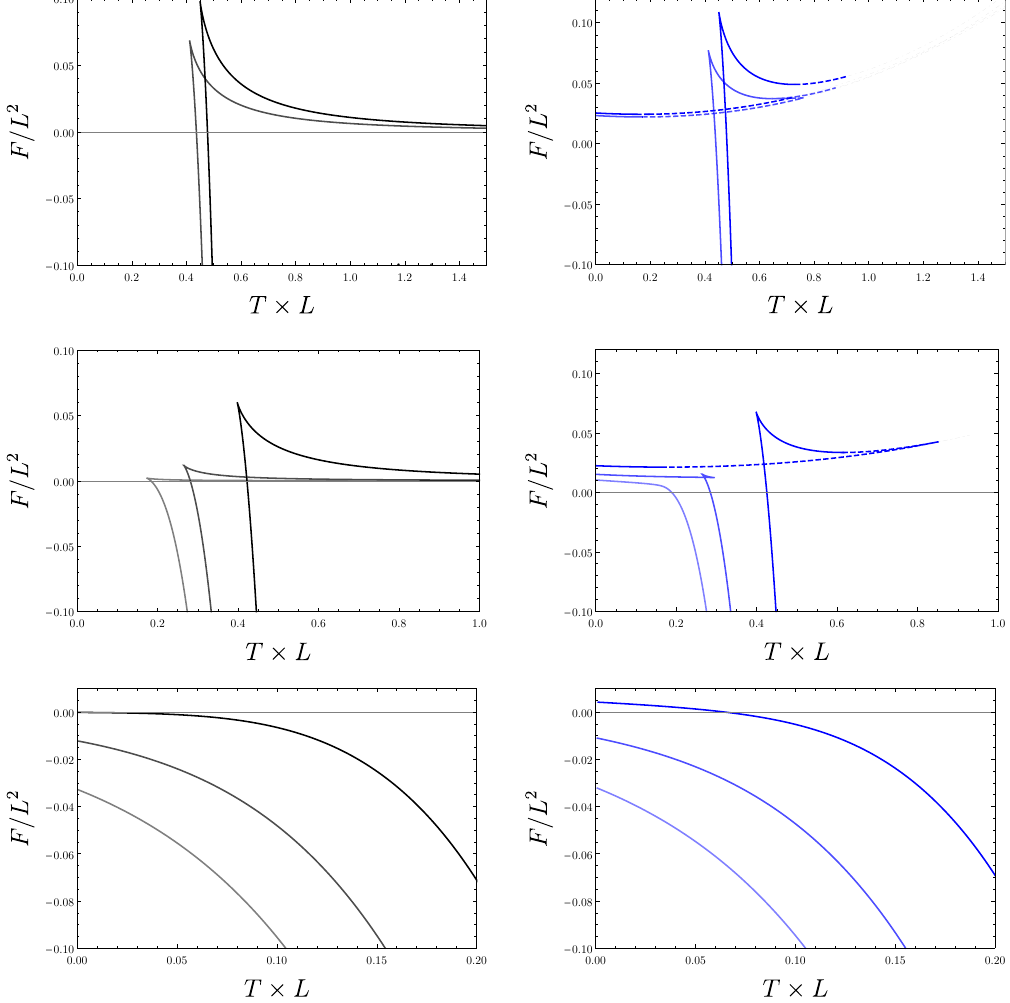
Figure 14 . Free energy: grand canonical ensemble in five dimensions . Top row : here we show plots of the free energy for Φ = 0 , 0 . 7 (more to less opacity) for Einstein gravity (left) and the cubic theory 3 (right). Middle row : here we show plots of the free energy for Φ = 0 . 81 , 1 . 2 , 1 . 6 with µ/µ = 10 − c (more to less opacity) for Einstein gravity (left) and the cubic theory with µ/µ Bottom row : here we show plots of the free energy for Φ = 1 . 75 , 1 . 9 , 2 . 0 (more to less opacity) for Einstein gravity (left) and the cubic theory with µ/µ portions of the blue curves indicate negative Wald entropy, and points where the blue curves simply terminate indicate that the mass has become